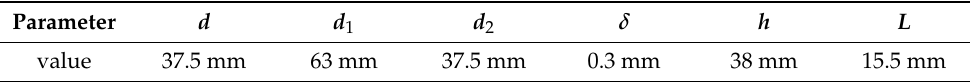
Table 3. The geometry parameters of the researched electric oil-filled joint actuator.